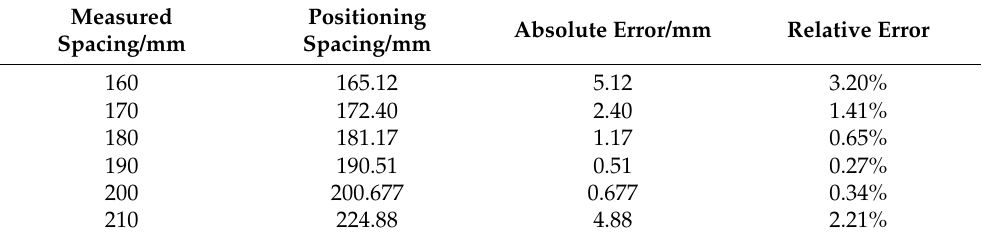
Figure 13. Image processing data curve of each interval.